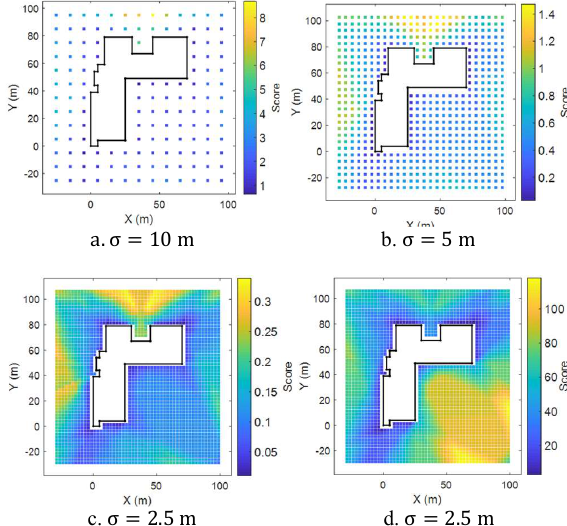
Figure 2. WGA score heatmaps for Example 2: VP candidates were created with various resolutions σ . Colours represent weighted scores in a, b and c, and binary scores in d.